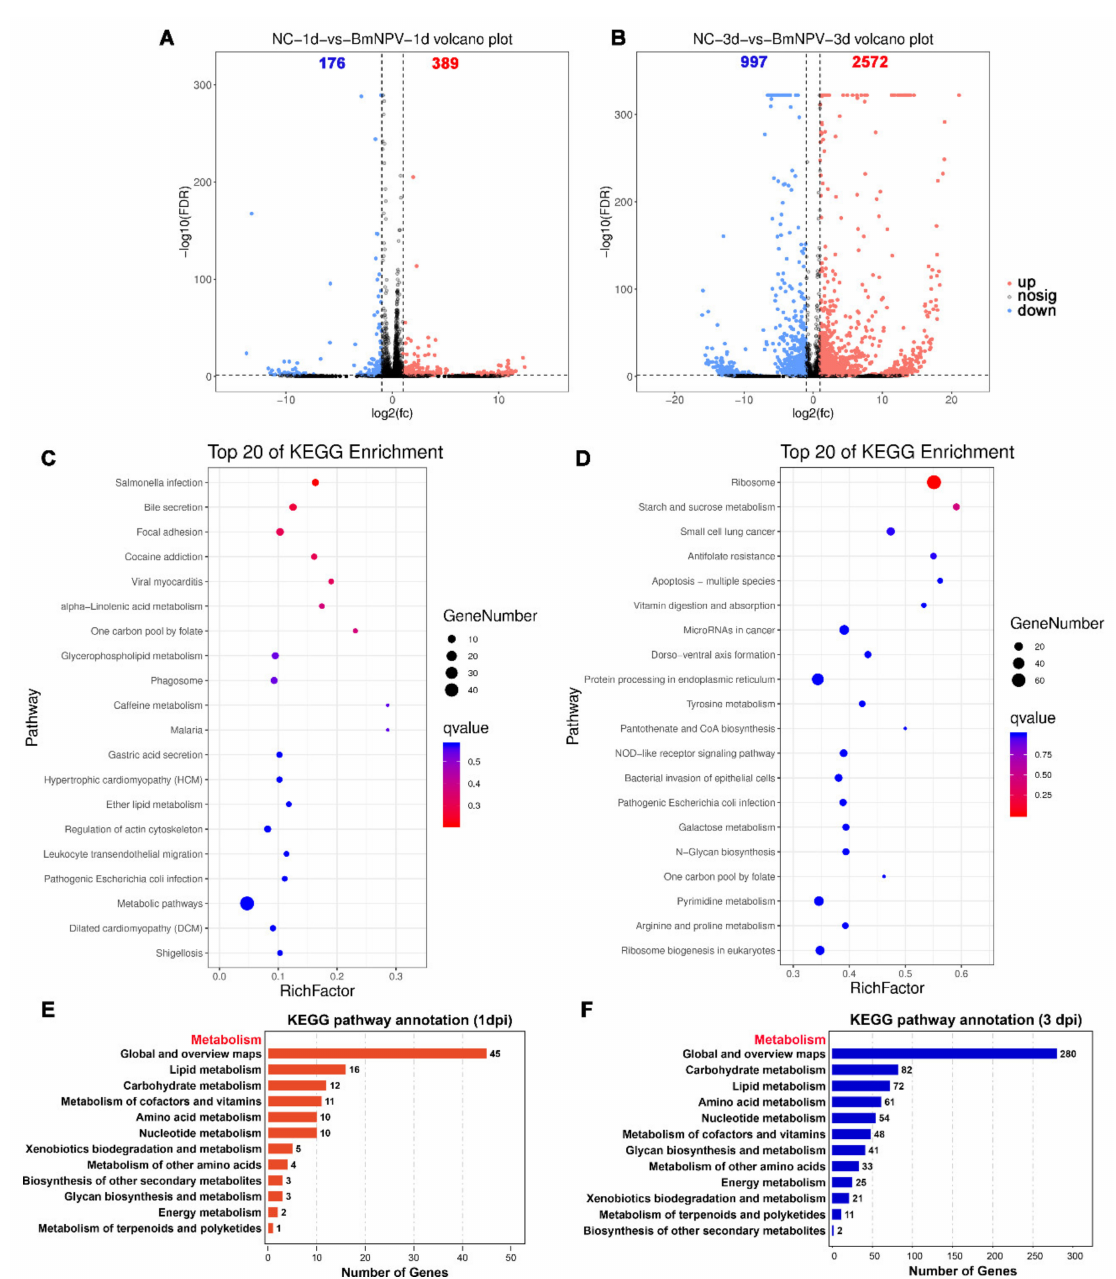
Figure 7. Analysis of DEGs in silkworm hemocytes after BmNPV infection. ( A , B ) Volcano plots of changes in gene expression in BmNPV-infected samples in comparison with uninfected hemocytes at 1 ( A ) and 3 dpi ( B ), respectively. Each point in the volcanic map represents a gene. Red: Up-regulated genes. Blue: Down-regulated genes. Gray: Not significant. ( C , D ) Top 20 KEGG-enriched pathways of DEGs in hemocytes of BmNPV-infected silkworm larvae at 1 ( C ) and 3 dpi ( D ). ( E , F ) The statistics of genes enriched in the KEGG class metabolism at 1 dpi ( E ) and 3 dpi ( F